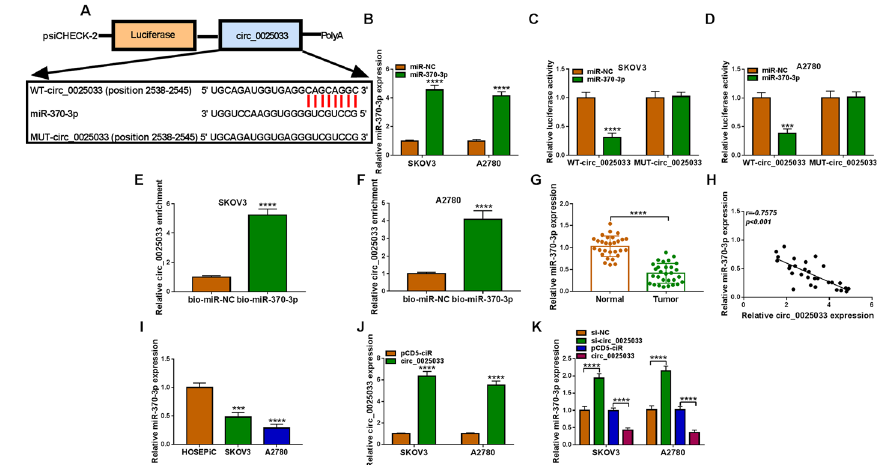
Fig. 3 hsa_miR-370-3p was a target of circ_0025033. A Circinteractome was used to predict the complementary sequence between hsa_miR-370-3p and circ_0025033. B Transfection efficiency